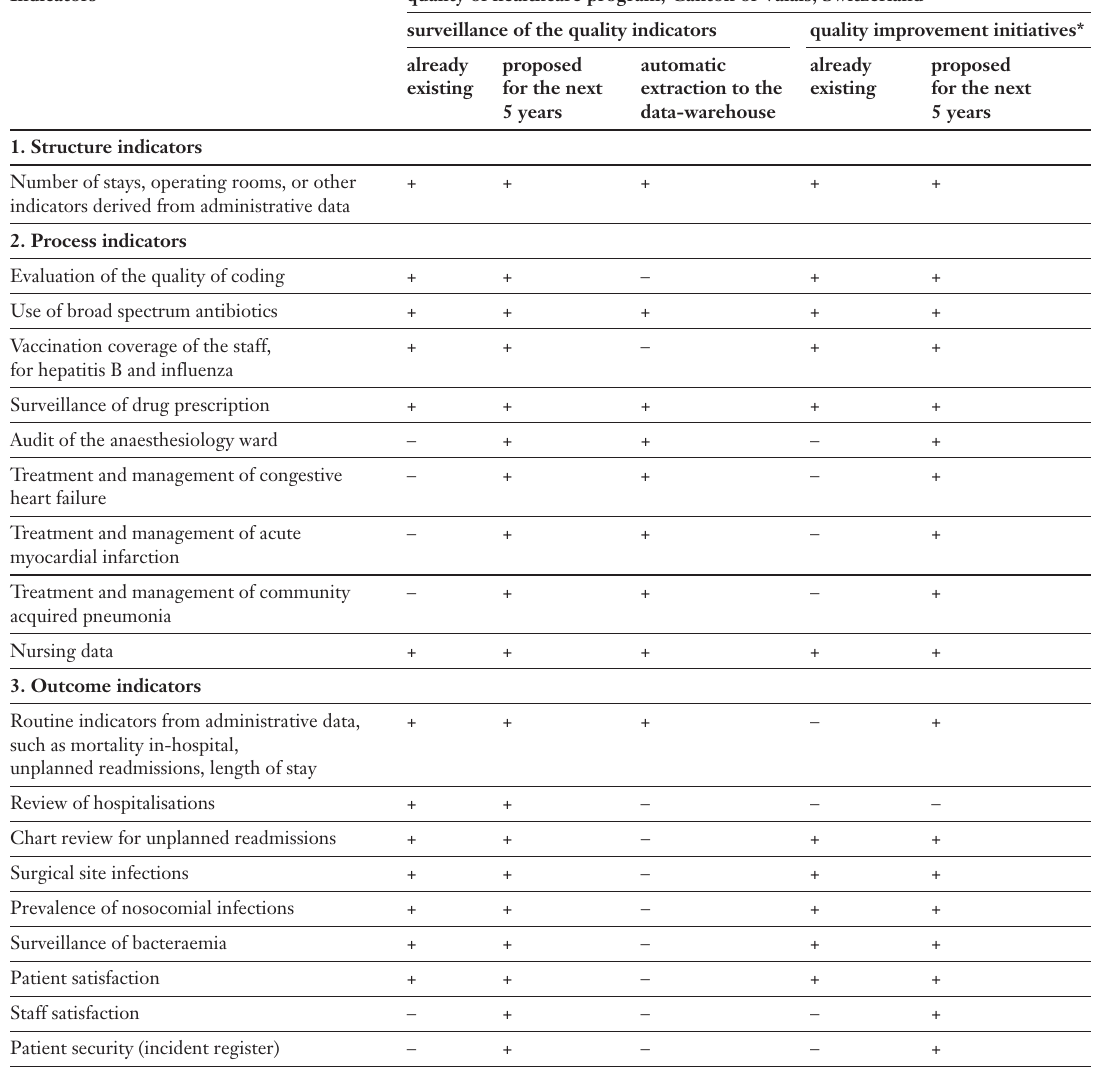
Table 1 Quality of Health Care Surveillance in the Canton of Valais: existing data and action plan for the next five